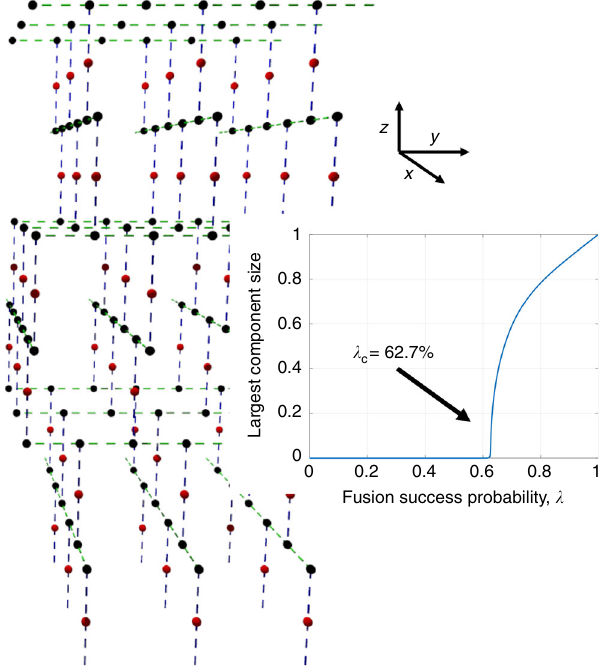
Fig. 5 Bond percolation on the modi fi ed (10,3)-b lattice. The ( x , y )-plane layers of parallel 1D line lattices of black (degree-3) nodes are stacked along the z direction. The layers alternate between the line lattices pointing in the x and y directions. Neighboring layers are straddled by a layer of red (degree-2) nodes. Along each line lattice of black nodes, the blue bonds alternate between the + z and − z directions. The adjective “ modi fi ed ” we use in the name of this lattice refers to the fact that in the standard (10,3)-b lattice, the red nodes are not present, i.e., the adjacent ( x , y ) planes of parallel lattices in alternating directions are directly connected via